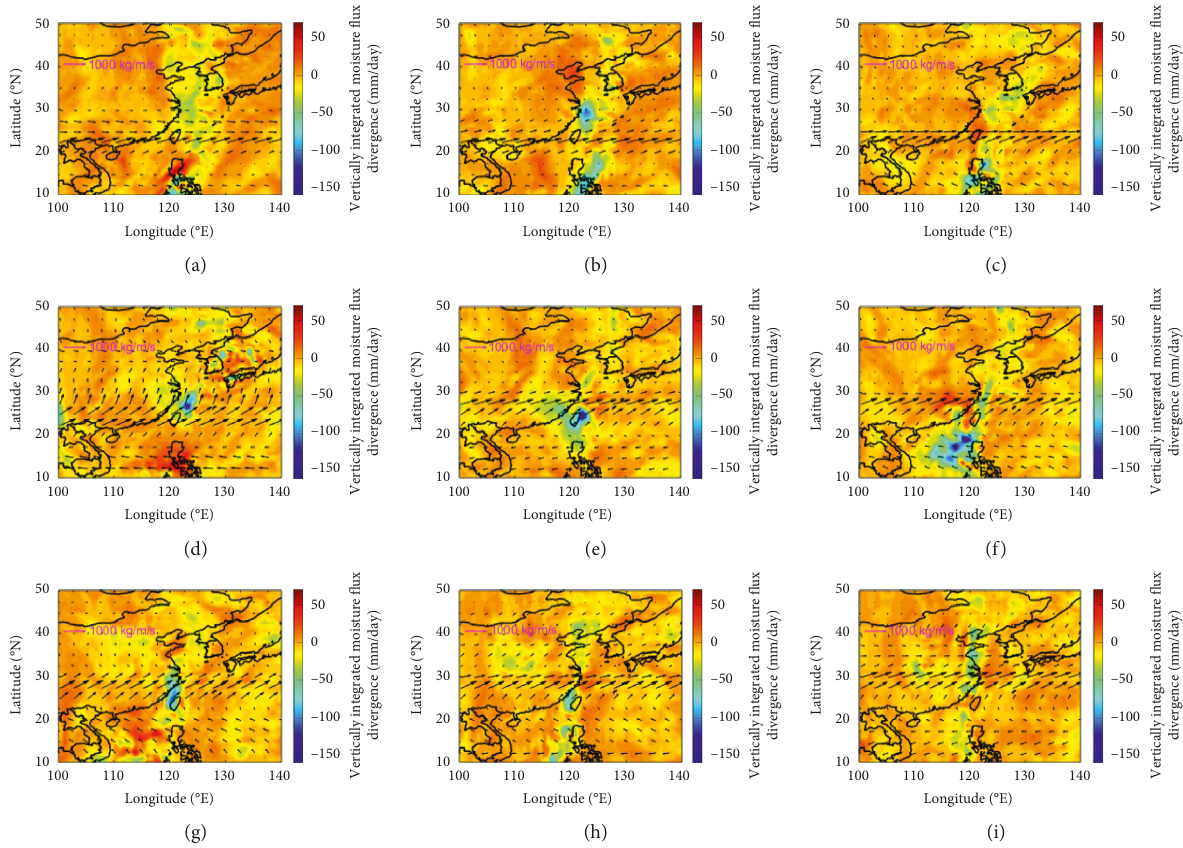
Figure 10: Vertically integrated moisture flux divergences (mm/day) from ERA-Interim products for days from 15 to 23 June 2017. Black arrows present IWT vectors (kg/m/s), with the scale at the top left of each panel. (a) 15 June 2017. (b) 16 June 2017. (c) 17 June 2017. (d)